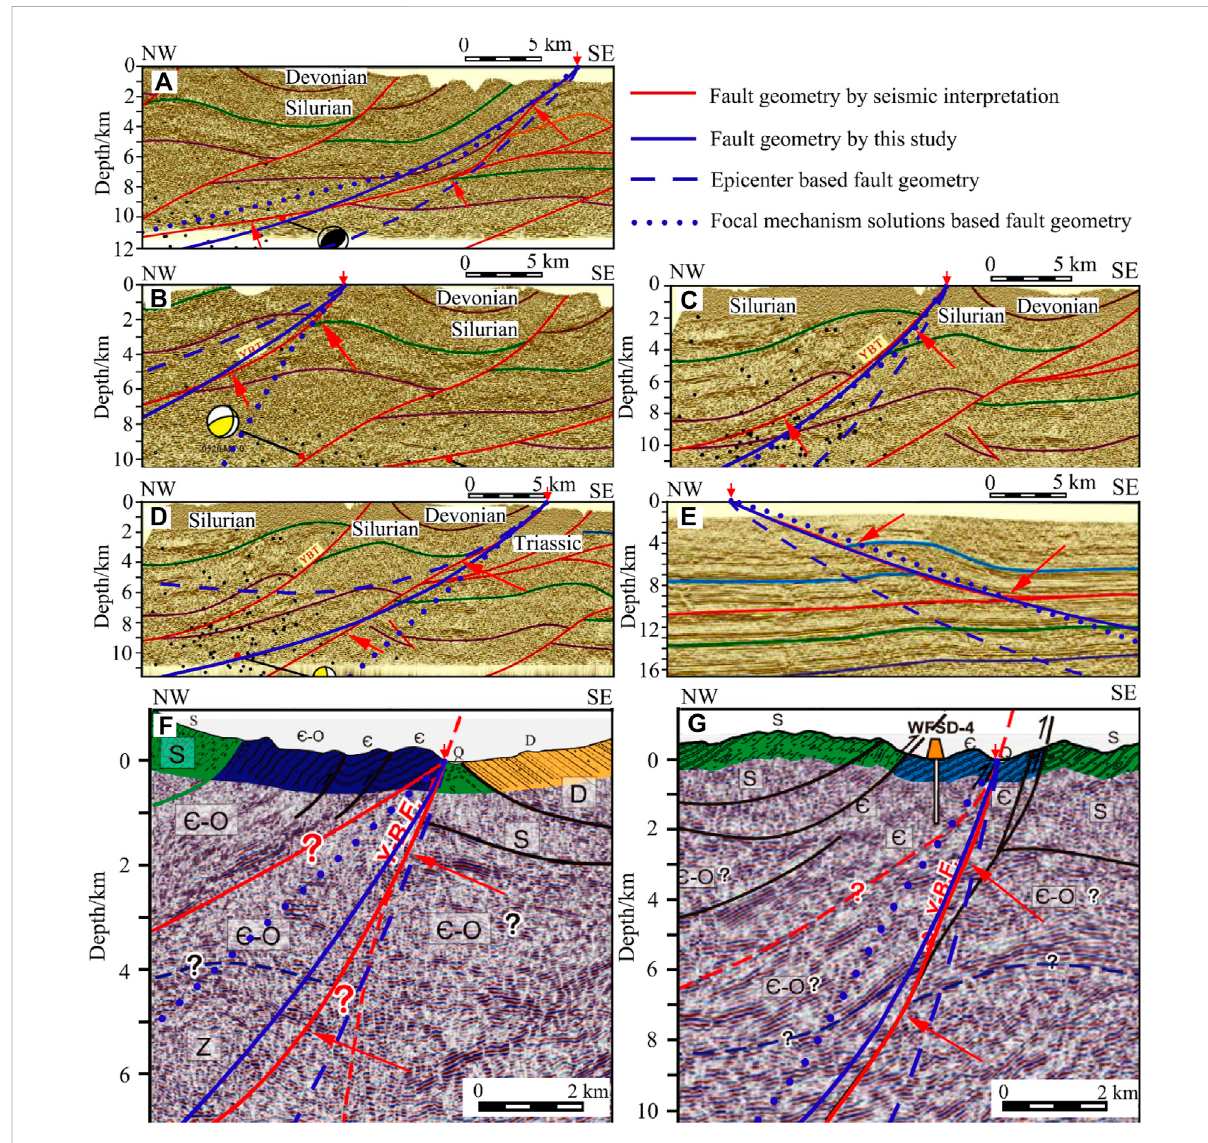
FIGURE 6 Comparison betweenthefault geometriesobtained from seismic interpretation and the fi tting results based on earthquake data. (A,B) are from Pro fi le #2 (Dong et al., 2010); (C,D) are from Pro fi le #5 (Dong et al., 2010); (E) is from Pro fi le #6 (Dong et al., 2010); (F) is from Pro fi le #4 (Wu et al., 2014); and (G) is from Pro fi le #3 (Wu et al.,